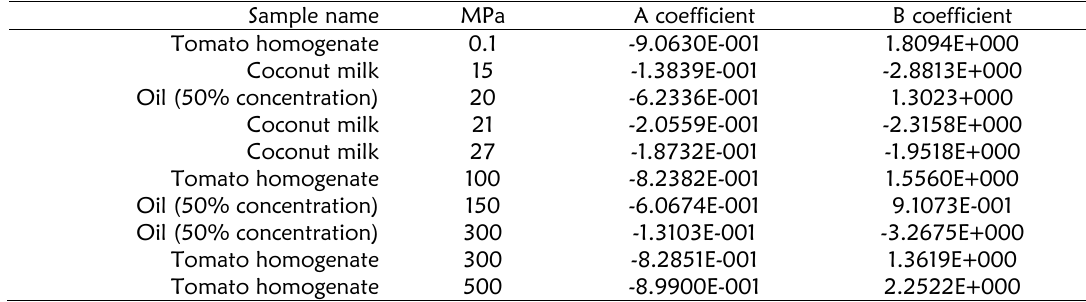
Table 1: Sample of coconut milk, oil with 50% mass fraction and tomato homogenate with different pressure and A and B coefficients obtained from equation (7) and data obtained from [11, 24,